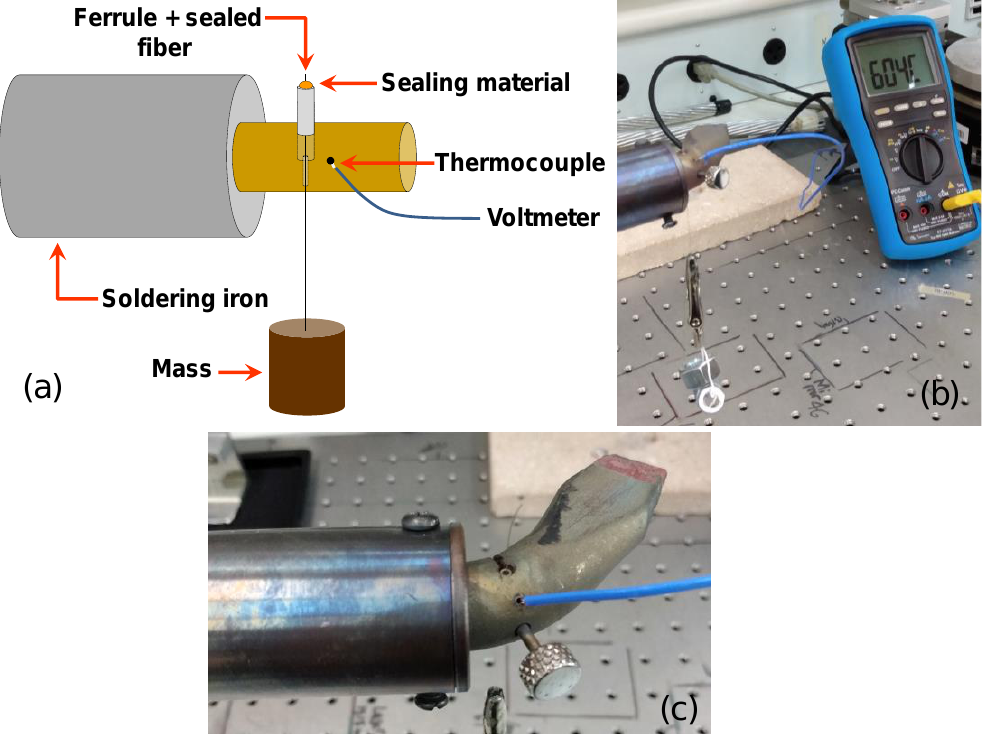
Figure 10. ( a ) Schematic of the setup utilized to test the endurance of sealing, ( b ) photo of the real setup and ( c ) zoom of the ferrule with the fiber sealed in the heating region of the soldering iron.